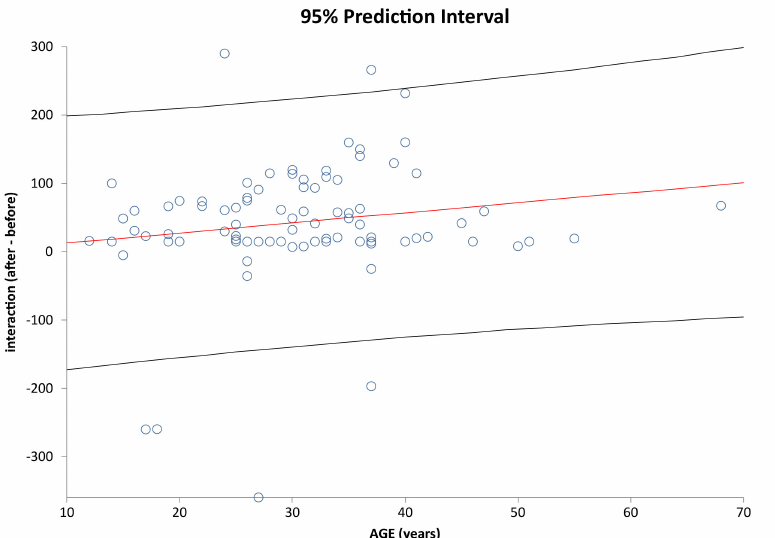
Figure 7. Prediction interval and linear regression line for Interaction (after-before) vs. Age in the investigated sample (correlation coefficient (r) = 0.160; p = 0.1416). Each circle represents a data point. The red line is the regression line (the linear model) and the black lines show the 95% prediction band for the forecasted Interaction (after-before).